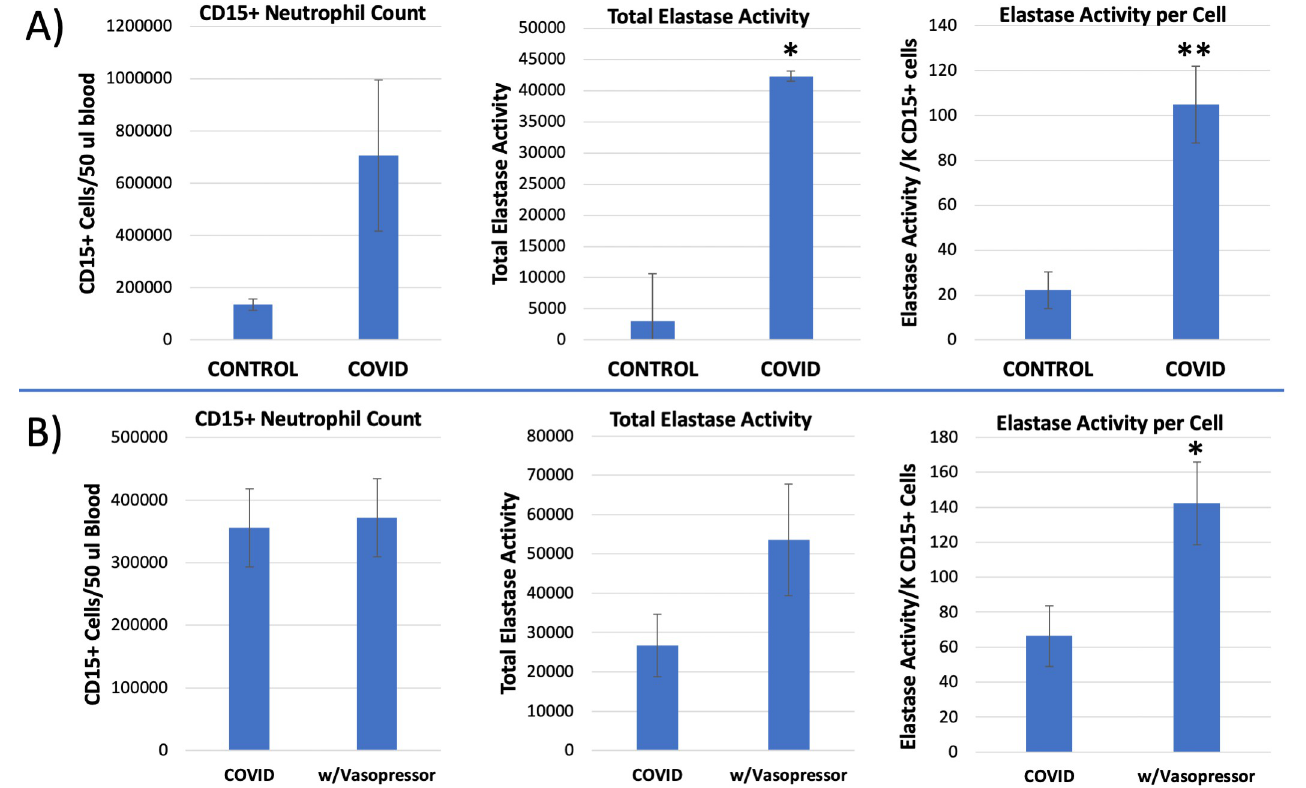
Fig 8. Neutrophil elastase activity of purified CD15+ neutrophils from control or COVID-19 patients. Panel A) Using the kinetic elastase assay shown in Fig 7, COVID-19 patient’s purified CD15+ neutrophils (n = 10) were compared to control subjects (n = 4). The left panel reports the total cell count of CD15 + neutrophils from 50 μ l of blood (mean ± s.e.m.). The total elastase activity of those cells was measured in arbitrary fluorescence units per 2 hour incubation (middle panel, mean ± s.e.m.). The total elastase activity per patient was divided by the CD15+ cell count for that patient to yield the elastase activity per cell (right panel, mean ± s.e.m.). Panel B) Patients that were PCR+ for SARS-CoV2, were regrouped according to whether they received vasopressor support (n = 4) or did not receive vasopressors (n = 8), ( � = p < 0.05, �� = p < 0.01).